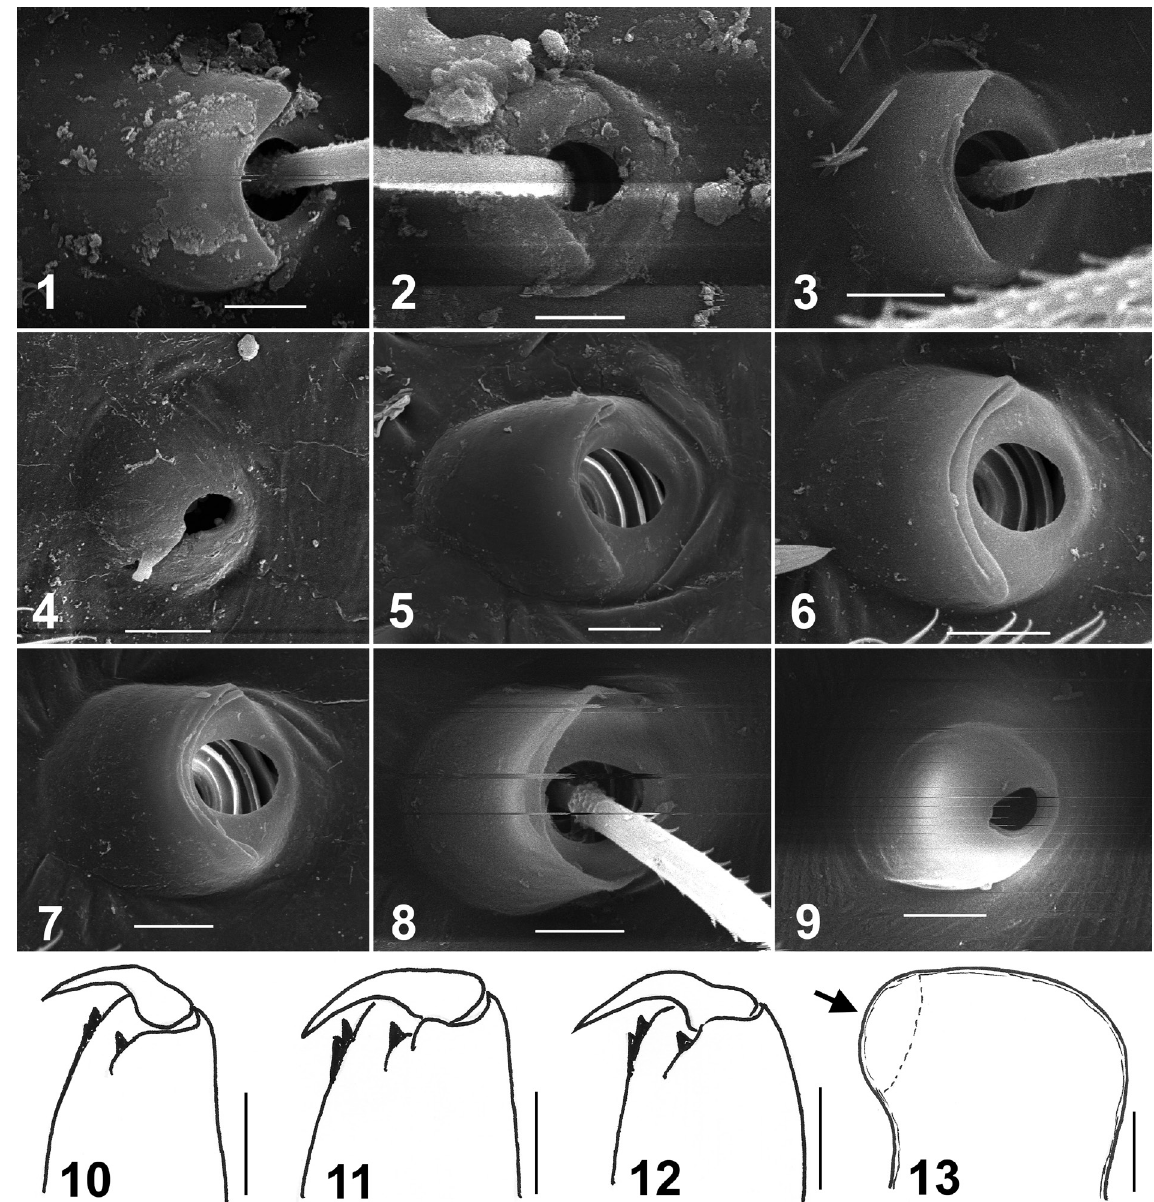
Figs 1–13. Trichobothrial bases (1–3, 5–8), tarsal organs (4, 9), left chelicerae (10–12) and right endite (13) of Stenaelurillus Simon, 1885. 1–2 . S. nigricaudus Simon, 1886, ♀. 1 . Tb 1. 2 . Tr 1. 3 . S.